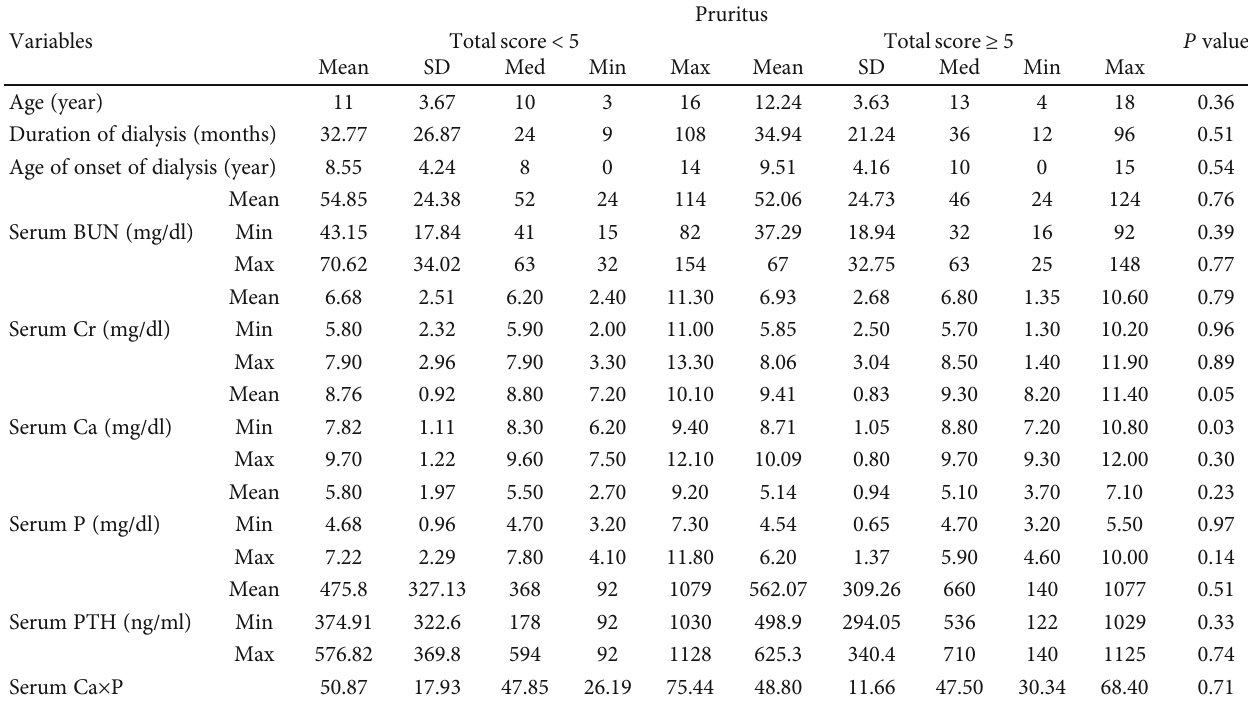
Table 4: Laboratory parameters and continuous variables chronic kidney disease (CKD) children with pruritus according to the total pruritus score.